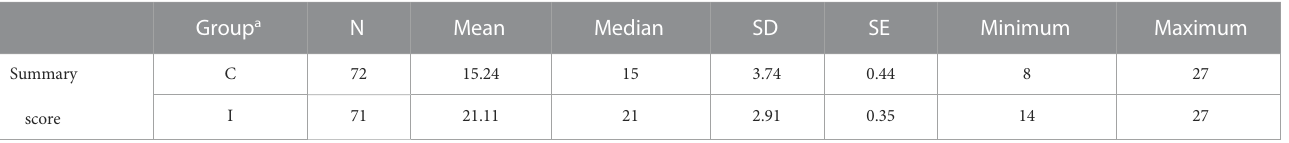
TABLE 7 Descriptive statistics of the summary medication management patient satisfaction score per